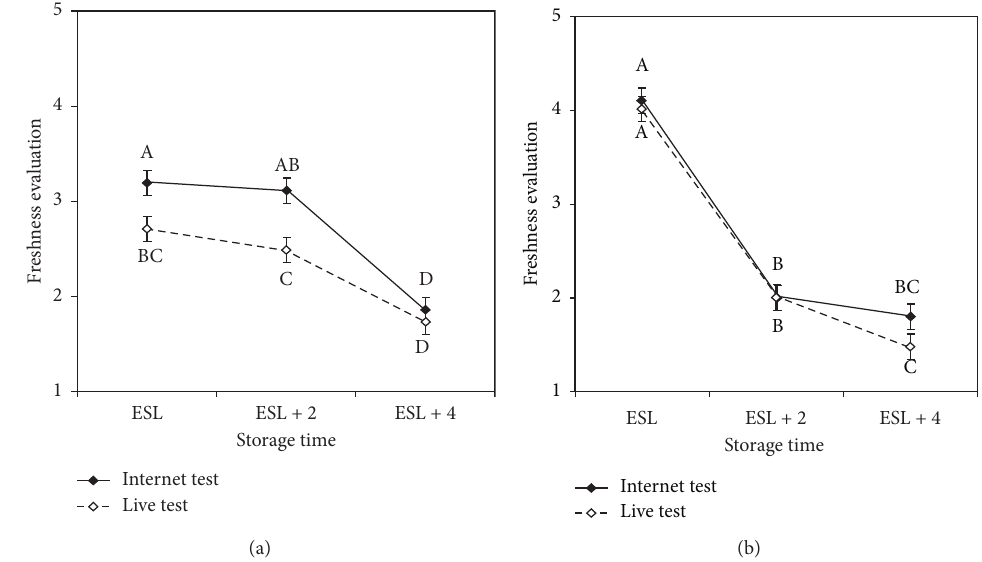
Figure 2: Freshness evaluation of vacuum-packed pig liver and modified atmosphere (MAP) from the end of the current shelf life (ESL). Results expressed as mean values and CI (95%). Means marked with different letters show significant differences ( p < 0 . 05). (a) VAC. (b) MAP. Table 1: Purchase intention of vacuum-packed and MAP pork liver.